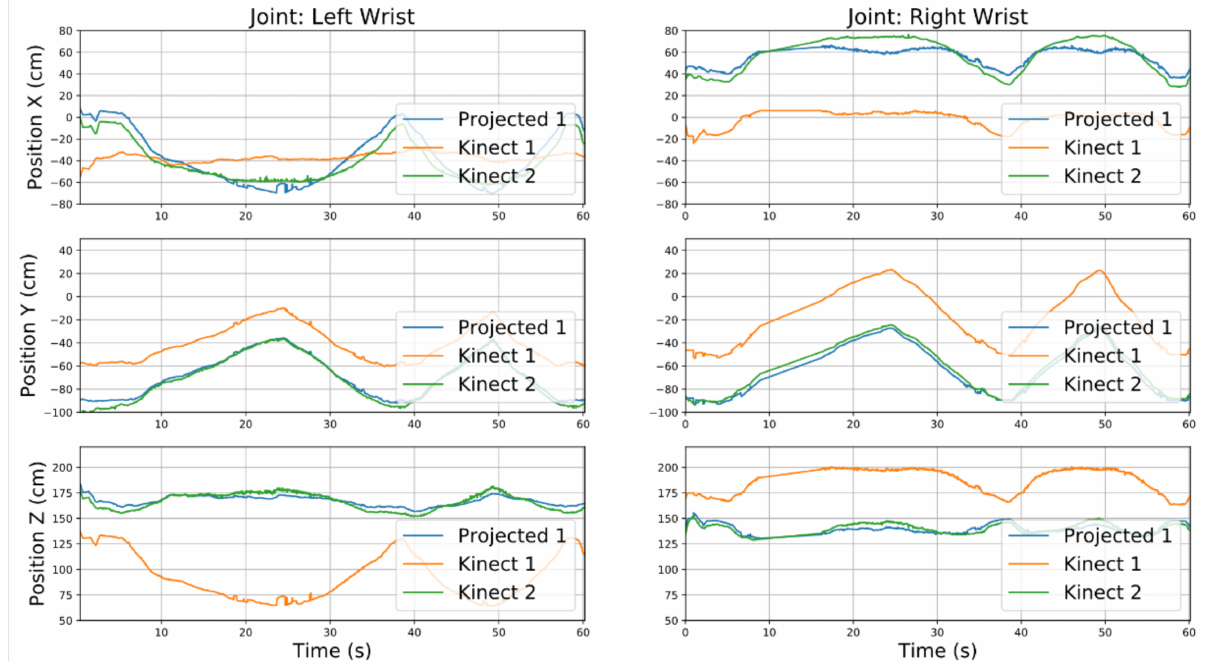
Figure 6. X, Y, and Z positions of left and right wrist by Kinect 1, Kinect 2, and projected